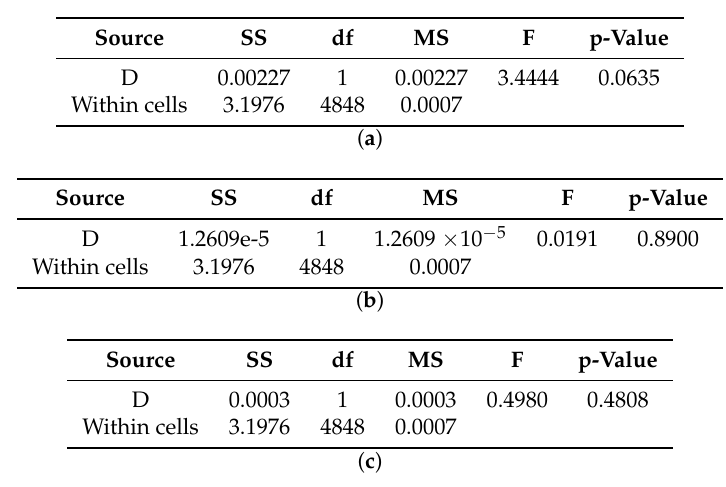
Figure A14. ANOVA tables for the analysis of the effect of factor D (speed of the obstacle) on the expected accuracy. ( a ) One-way ANOVA for factor D given C = 1. ( b ) One-way ANOVA for factor D given B = 1 and C = 2. ( c ) One-way ANOVA for factor D given B = 2 and C =